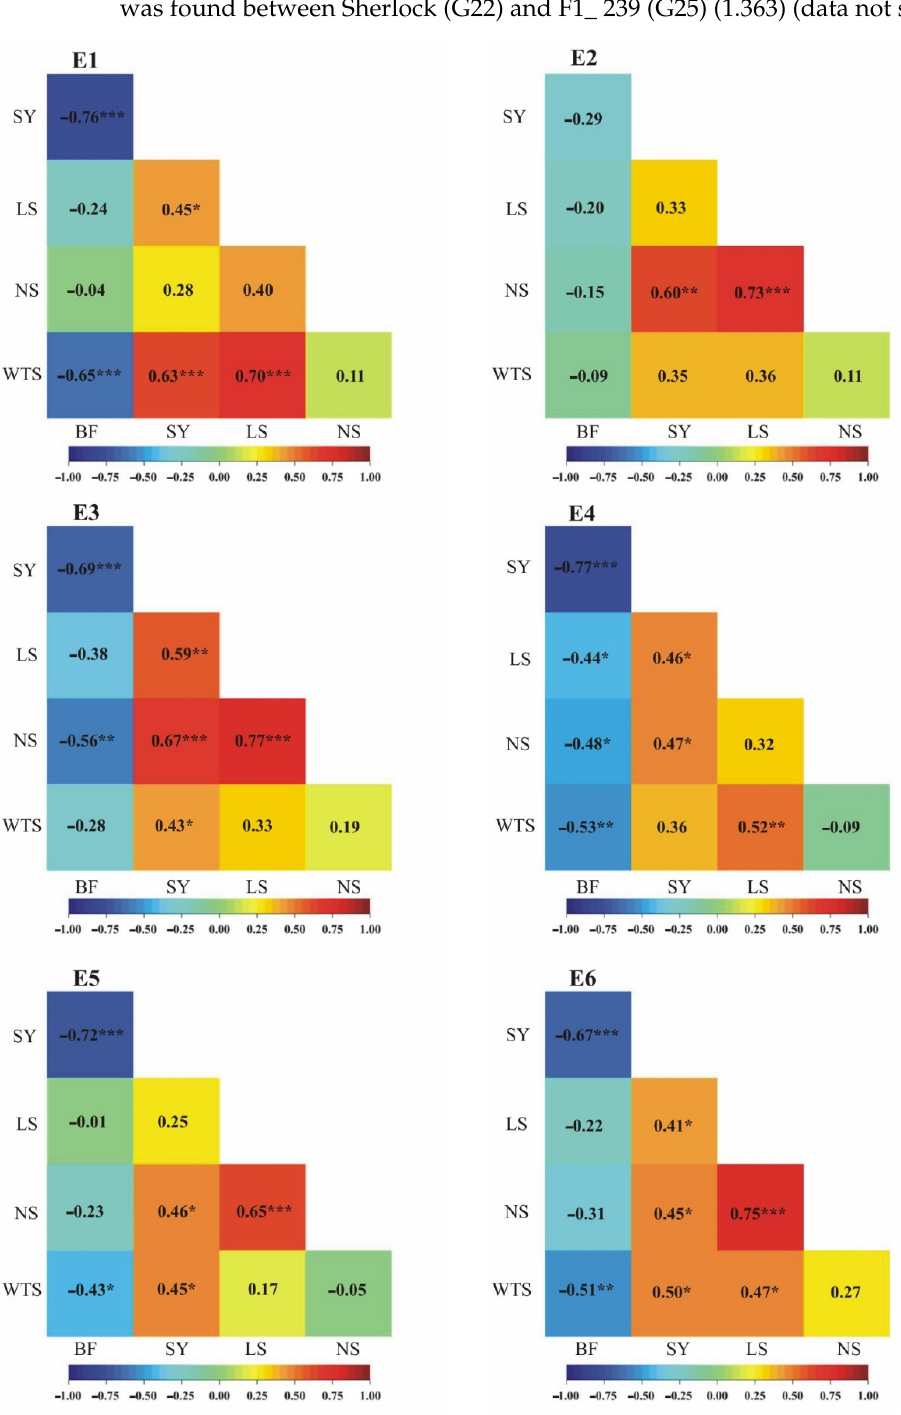
Figure 1. Heatmaps for linear Pearson’s correlation coefficients between the observed traits on the basis of mean values for genotypes. BF—the beginning of flowering, SY—seed yield, LS—length of silique, NS—the number of seeds per silique, WTS—weight of 1000 seeds. E1—Borowo, 2015, E2—Borowo, 2016, E3—Borowo, 2017, E4—Łagiewniki, 2015, E5—Łagiewniki, 2016, E6—Łagiewniki, 2017. * p < 0.05, ** p < 0.01; *** p < 0.001.